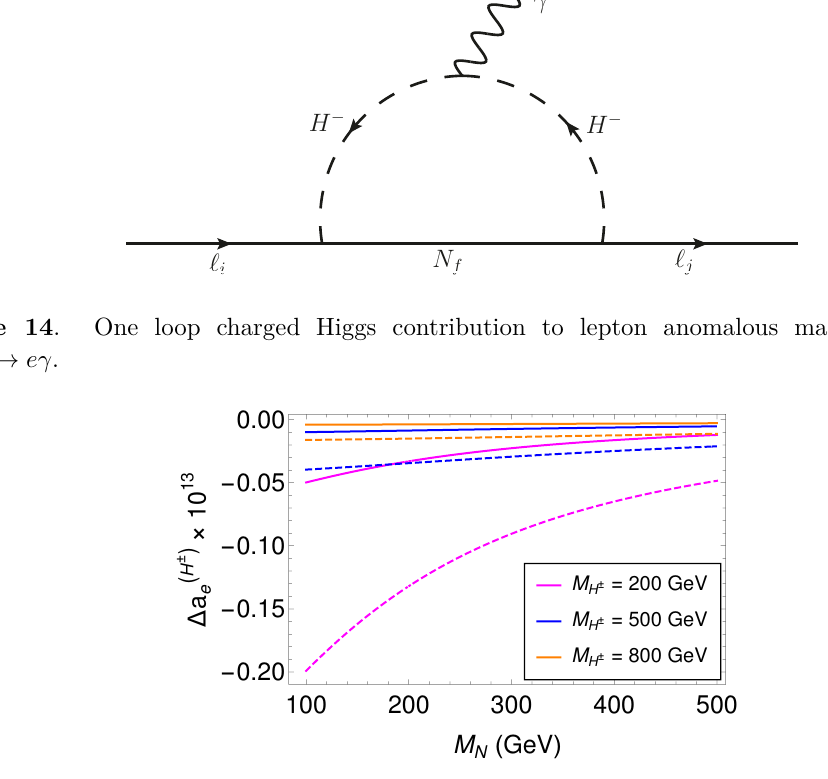
Figure 15 . Plot shows the variation of the electron magnetic moment with the mass of RHNs for three different values of charged scalar mass M as denoted by the legends. We have plotted each H ± curve for two different values of R 1 : R 1 = 0 . 5 (solid) and R 1 = 1 . 0